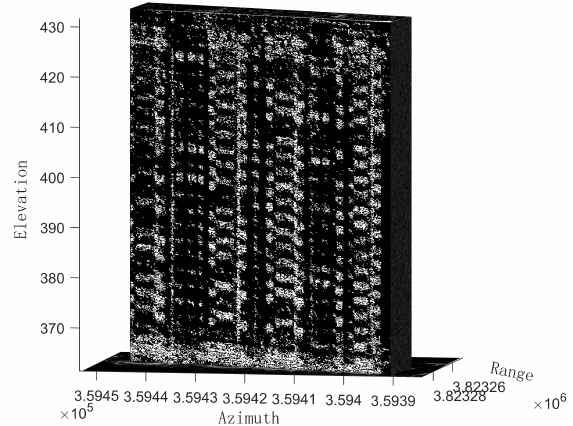
Figure 17. 3D reconstruction